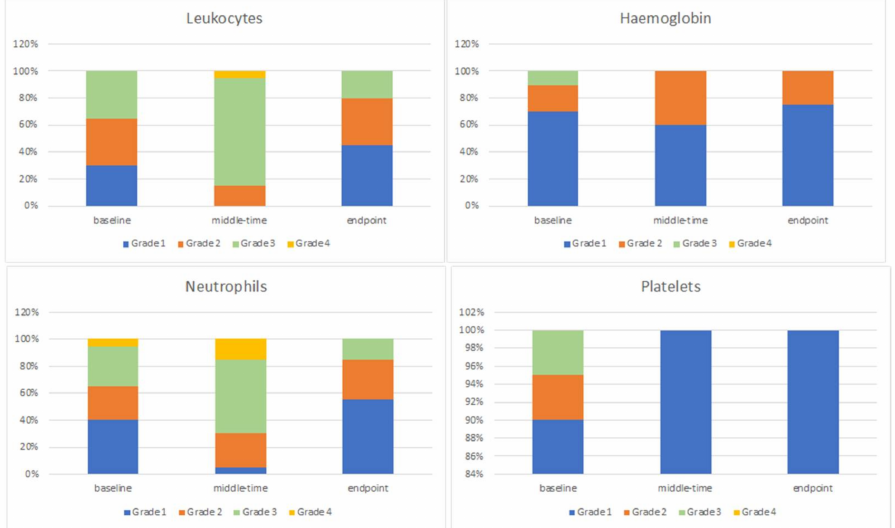
Figure 3. Grade of toxicity at different timepoints, classified according to CTCAE 5.0v for leukocyte, neutrophils, hemoglobin, and